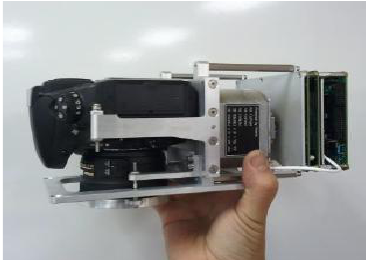
Figure 16: Applanix AP20 DMS and Nikon